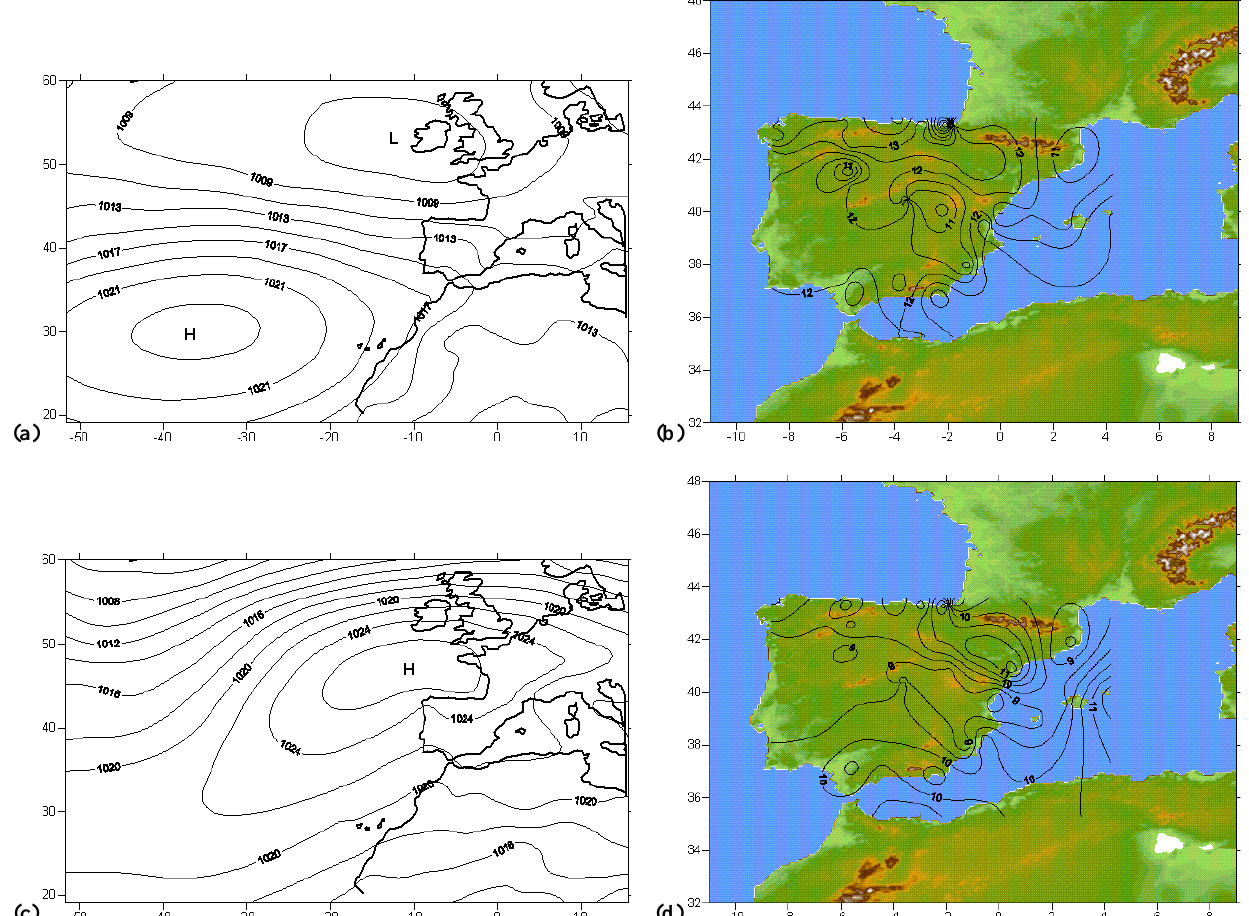
Fig. 6. Composite anomaly maps of the first mode: (a) MSLP (hPa) and (b) wind gust (ms − 1 ) corresponding to the positive composite. (c) MSLP (hPa) and (d) wind gust (ms − 1 ) corresponding to the negative composite. This figure is available in colour